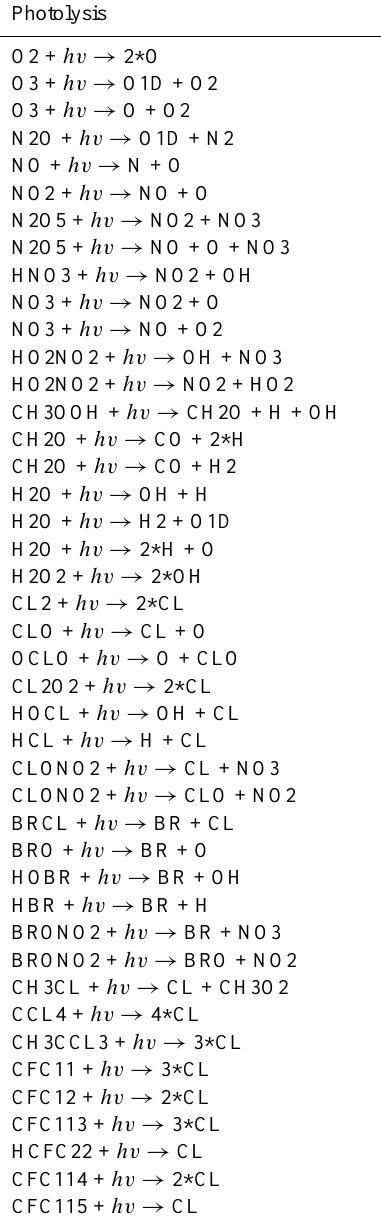
Table A2. Chemical reactions in